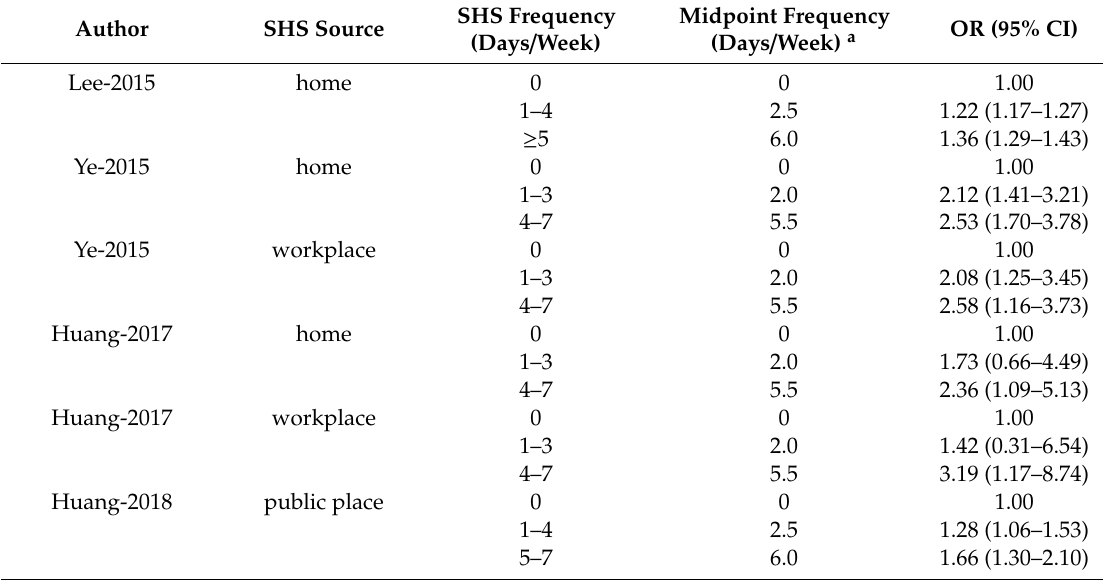
Table 4. Epidemiological studies of frequency of SHS exposure (days / week) and depressive